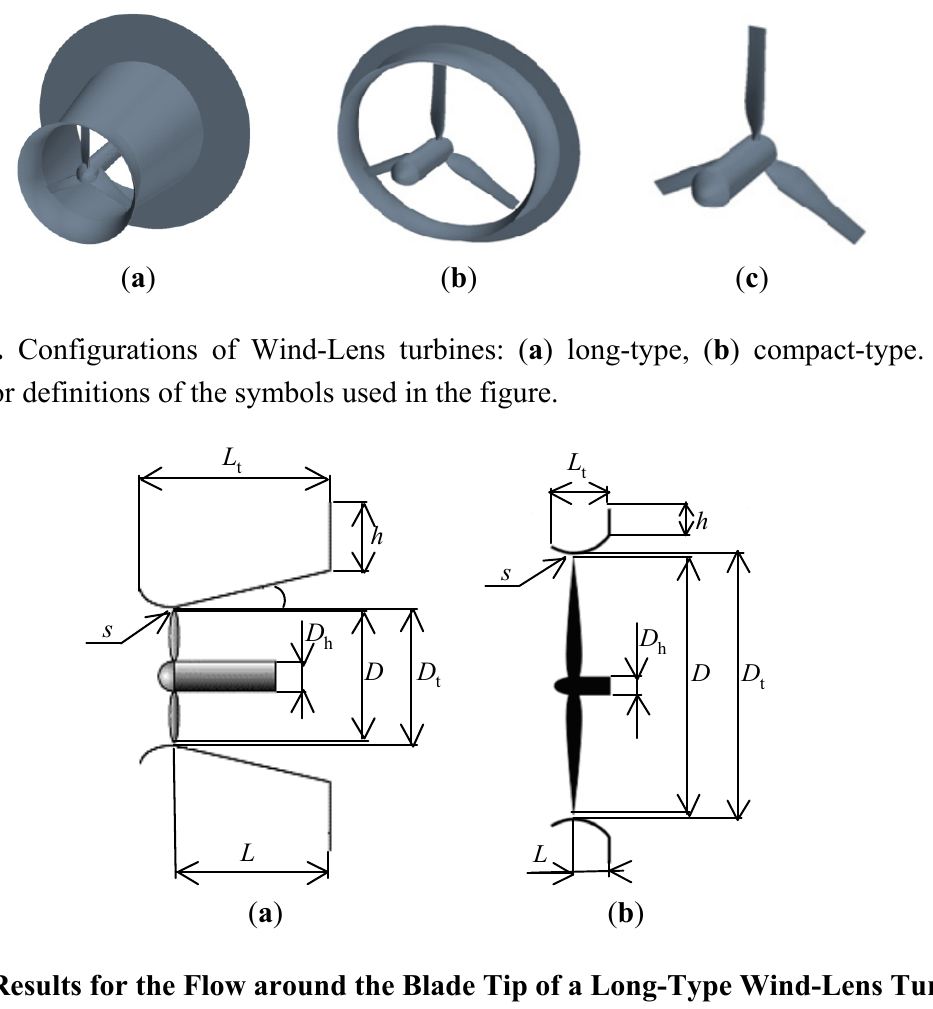
Figure 6. Objects considered in the simulations: ( a ) long-type Wind-Lens turbine; ( b ) compact-type Wind-Lens turbine; ( c ) bare wind turbine.